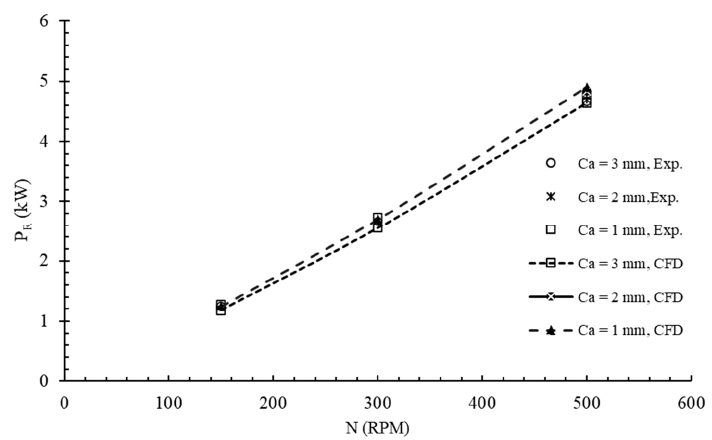
Figure 6. Comparison of experimentally and numerically obtained power draw